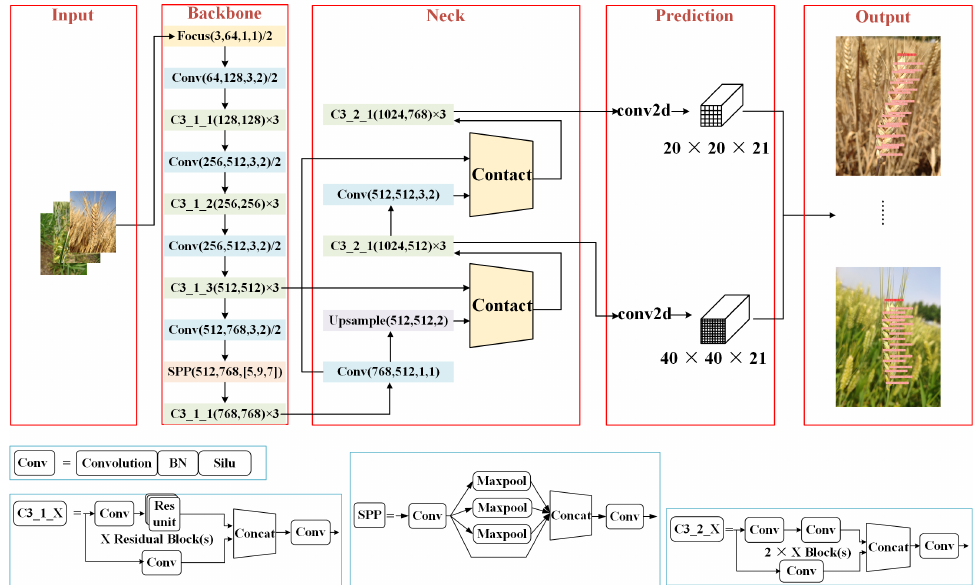
Figure 3. YOLOv5s-T network structure.